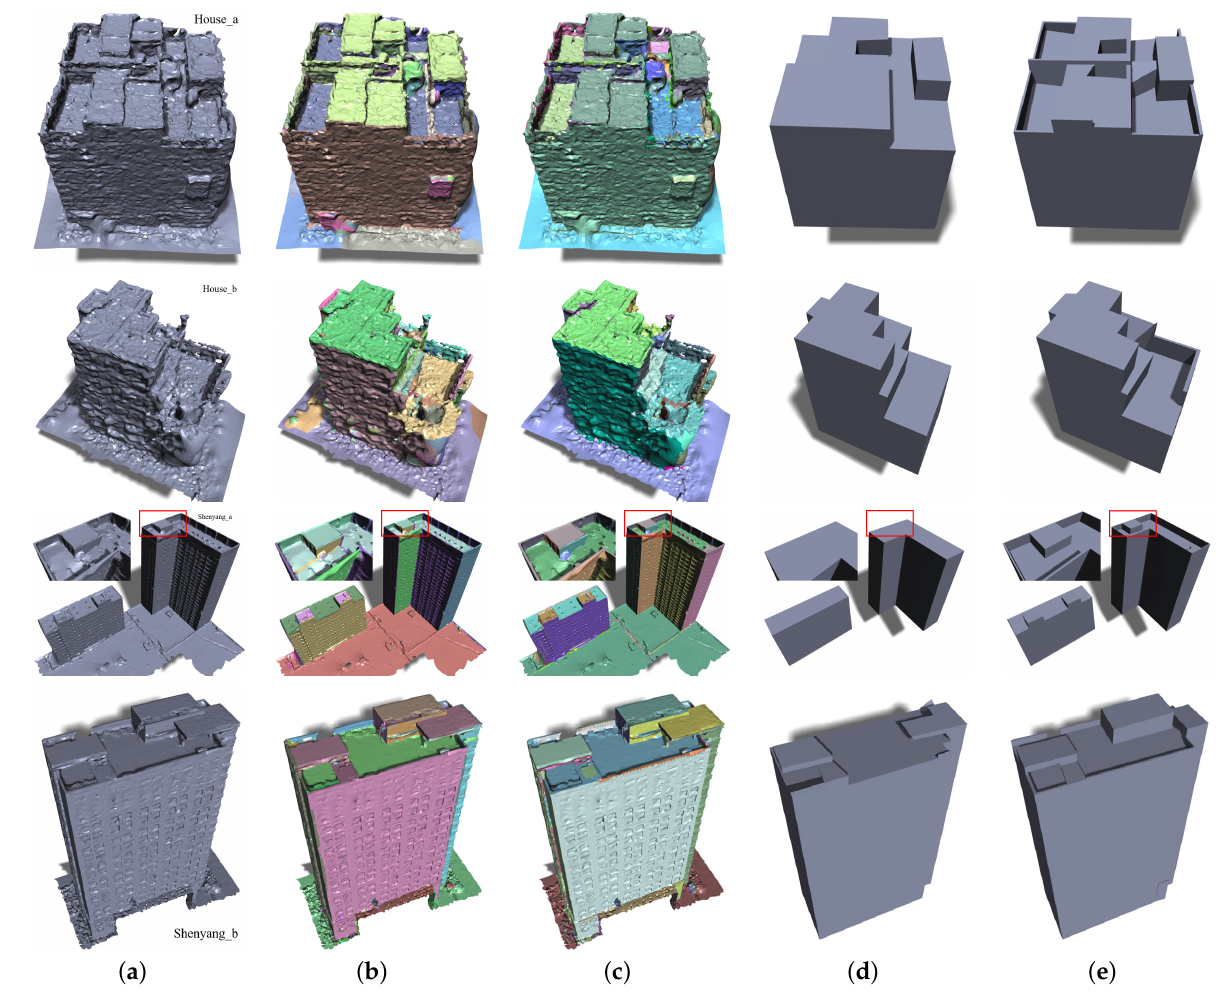
Figure 12. Comparison of segmentations and polyhedrals of thin plate structures with